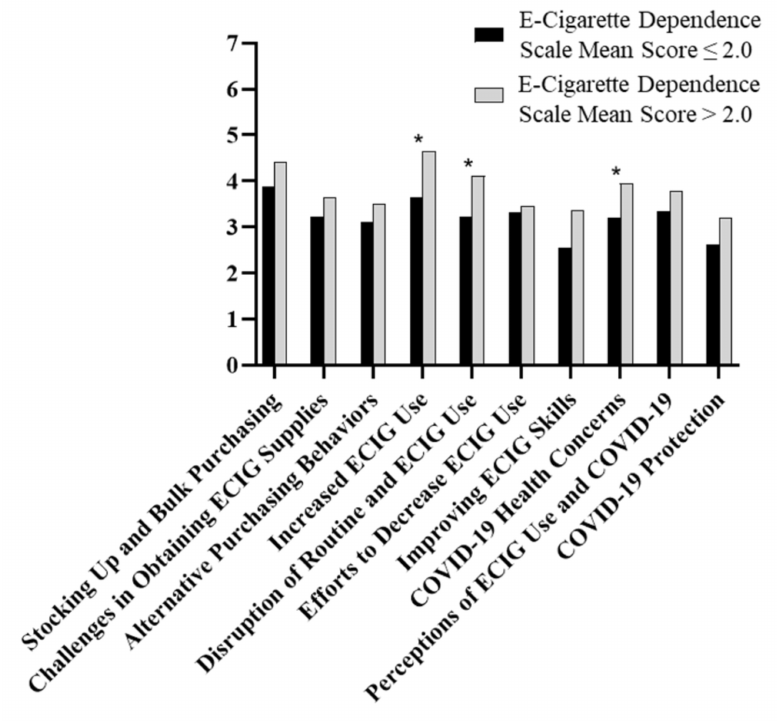
Figure 2. Mean cluster ratings among participants with E-Cigarette Dependence Scale [18] mean scores ≤ 2.0 and > 2.0. * indicates significant di ff erence ( p < 0.05). ECIG users who also reported current cigarette use (i.e., dual-users) had higher mean cluster ratings than non-current cigarette smokers for the Stocking Up and Bulk Purchasing cluster (M = 4.44 vs. 3.69; p < 0.05), E ff orts to Decrease ECIG Use cluster (M = 3.71 vs. M = 3.02; p < 0.05), Improving ECIG Skills cluster (M = 3.48 vs. M = 2.27; p < 0.05), Increased ECIG Use cluster (M = 4.34 vs. M = 3.72; p < 0.05), and Disruption in Routine and ECIG Use cluster (M = 4.07 vs. M = 3.04; p <